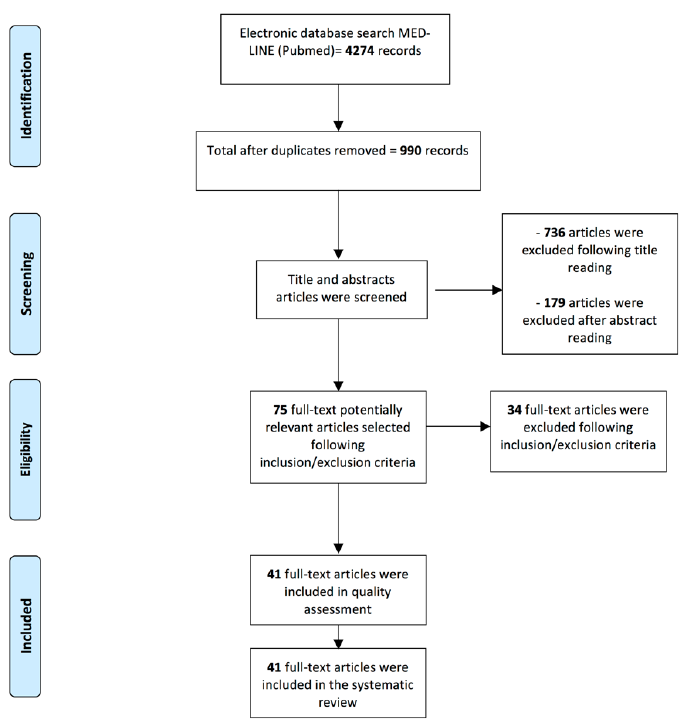
Figure 1. Flowchart of the review process and search strategy according to PRISMA statement.